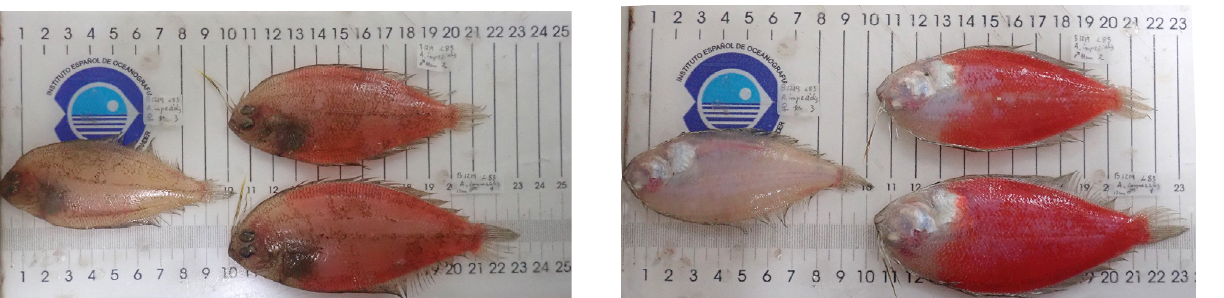
Fig. 4. – Arnoglossus blachei Stauch, 1965, B1219, L83, one female (left) and two males (right), Guinea-Bissau. Photographs of fresh specimens taken by Pere Oliver Reus. Blind